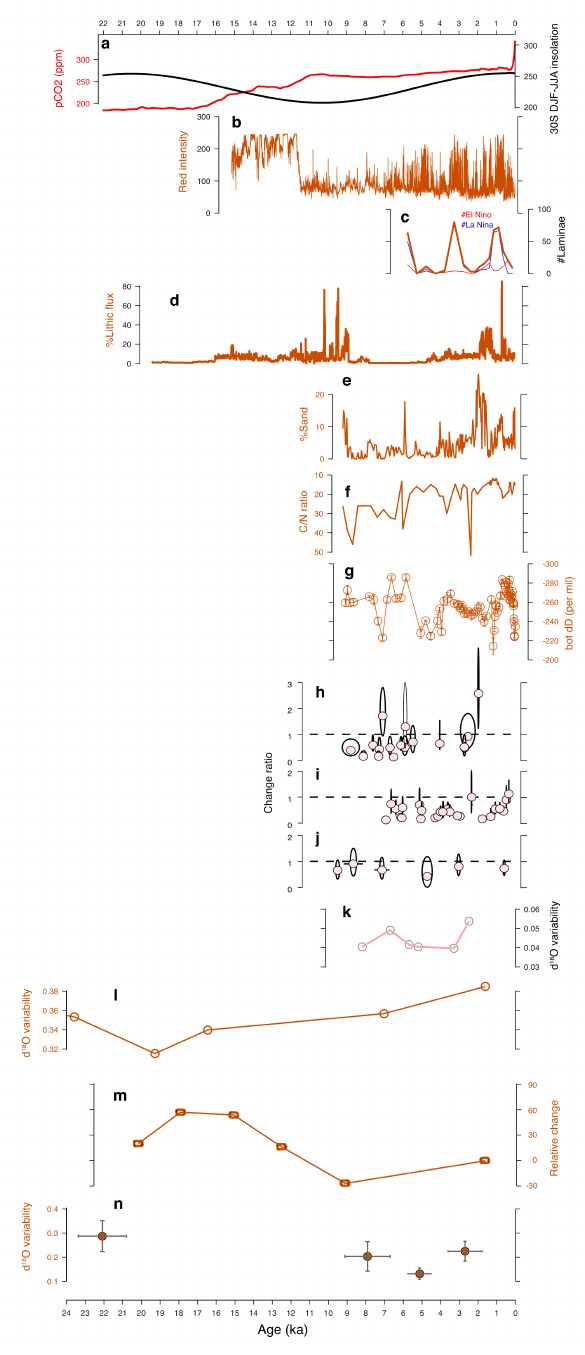
Figure 3. Time series of external forcings and ENSO variability revealed by proxy reconstructions (with the corresponding colors to Figure 1) since the Last Glacial Maximum. ( a ) CO 2 concentration (red) and DJF-JJA insolation at 30 ◦ S (black); ( b ) Red laminae intensity in Laguna Pallcacocha record [22]; ( c ) El Nino (thin red) and La Nina (thin blue) events [26] in Bainbridge Crater Lake [23]; ( d ) Lithic flux in a marine sediment from off Peru (% of maximum) [27]; ( e – g ) El Junco sand record and C/N ratio [24] and botryococcene concentration [25]; ( h – j ) Coral and mollusk synthesis of δ 18 O variability from Western Pacific (WP), Central Pacific (CP) and Eastern Pacific (EP) clusters [33]; ( k ) δ 18 O variability from speleothem [34]; ( l – n ) δ 18 O variability in marine sediment records from the tropical eastern Pacific